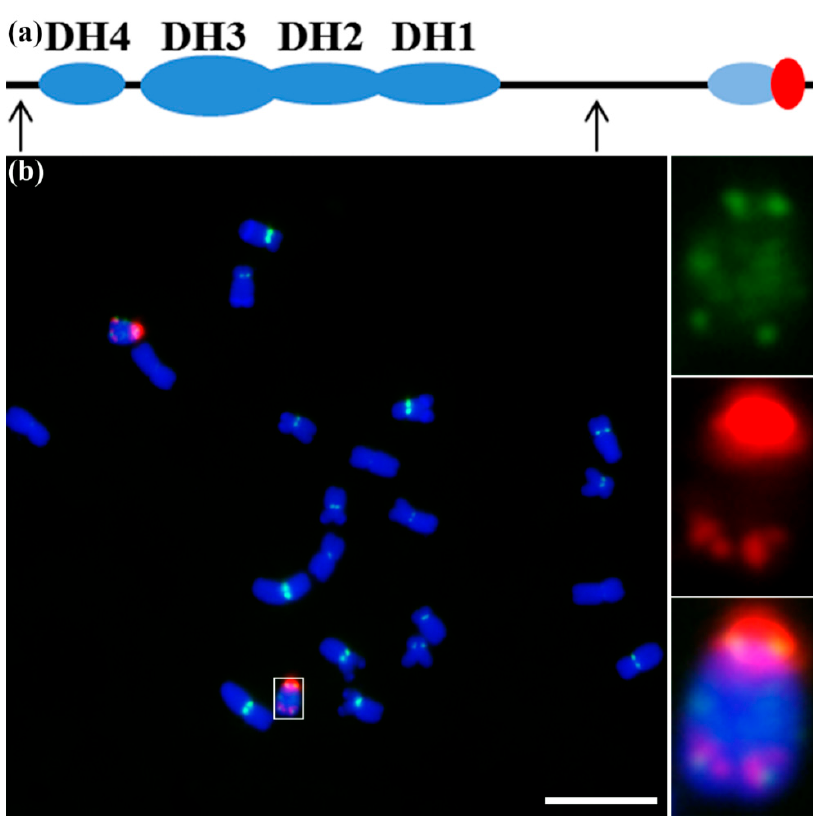
Figure 1. The structure and organization of the maize B chromosome and its centromere. ( a ) Diagram of the maize B chromosome with centric heterochromatin, four heterochromatic blocks (DH1–DH4) in the long arm, and two euchromatic regions—one proximal and one distal. The red oval indicates the centric heterochromatin. The light-blue oval indicates the knob signals. The two arrows indicate the two potential regions that are essential for nondisjunction. ( b ) The distribution of CentC (green) and maize B centromere repeat sequence (B-repeat) (red) signals along the maize B chromosome. The white box indicates the B chromosome, and the insets show a higher magnification view of the B chromosome. 4 ′ ,6-diamidino-2-phenylindole (DAPI)-stained chromosomes are blue. Bar = 10 μ m.